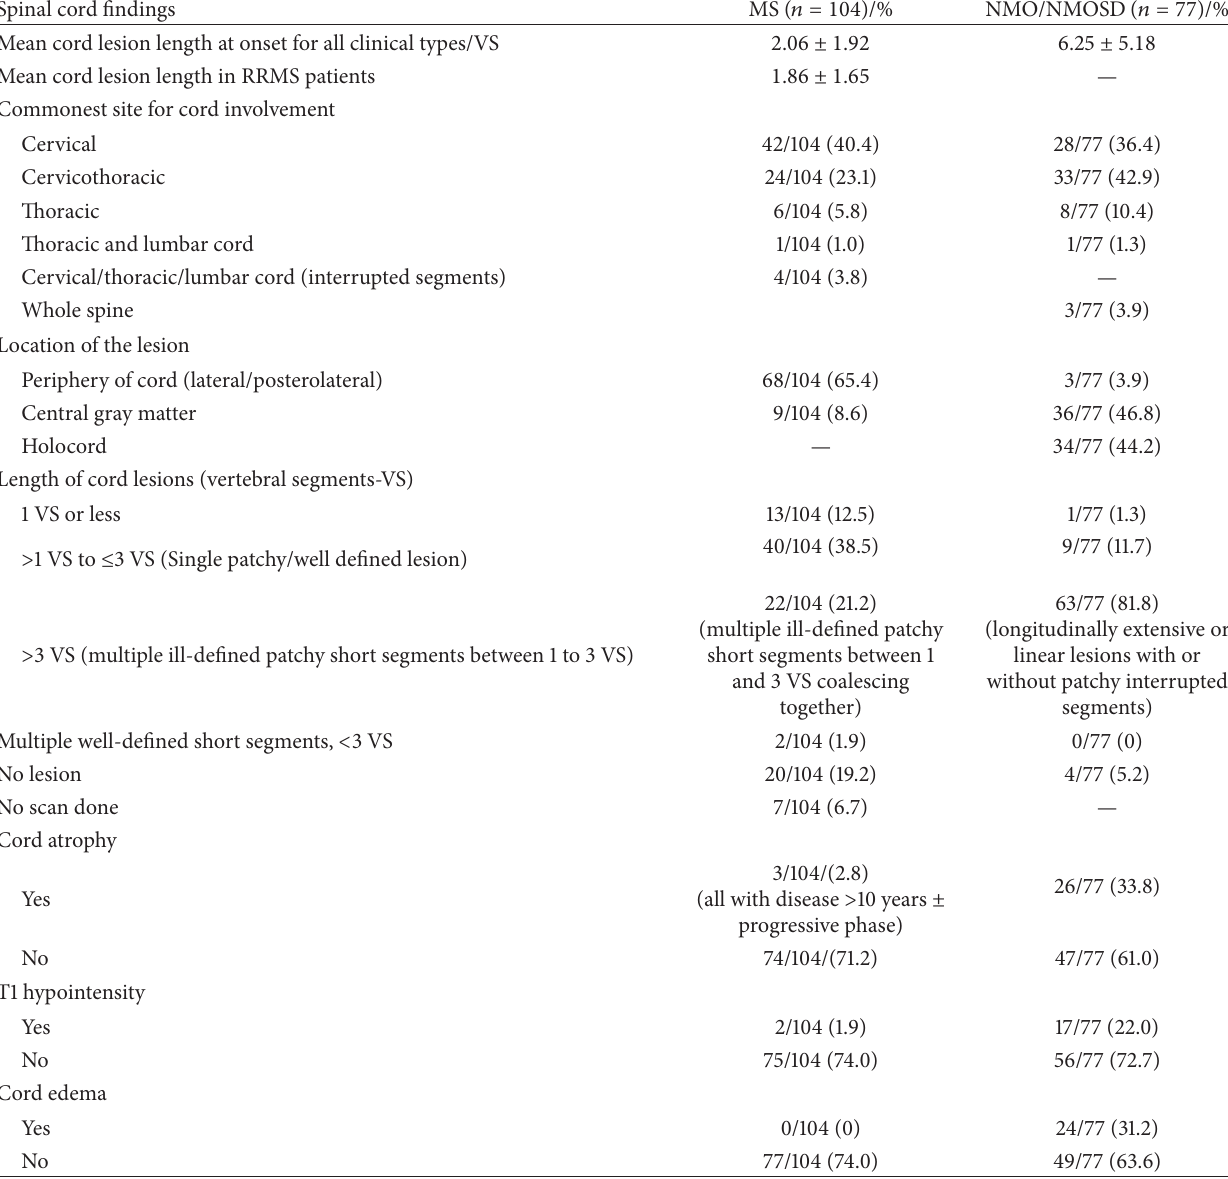
Table 3: Neuroimaging of the spine in patients with multiple sclerosis and neuromyelitis optica and its spectrum disorders in Malaysia. Spinal cord findings Mean cord lesion length at onset for all clinical